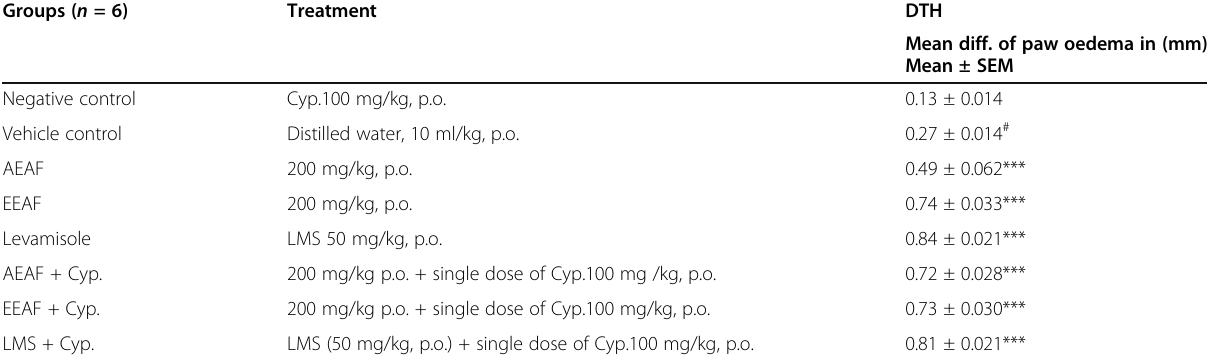
Table 8 Effect of aqueous and ethanolic extract of A . ficulneus L. leaves on delayed type of hypersensitivity (DTH) in mice Groups ( n = 6)